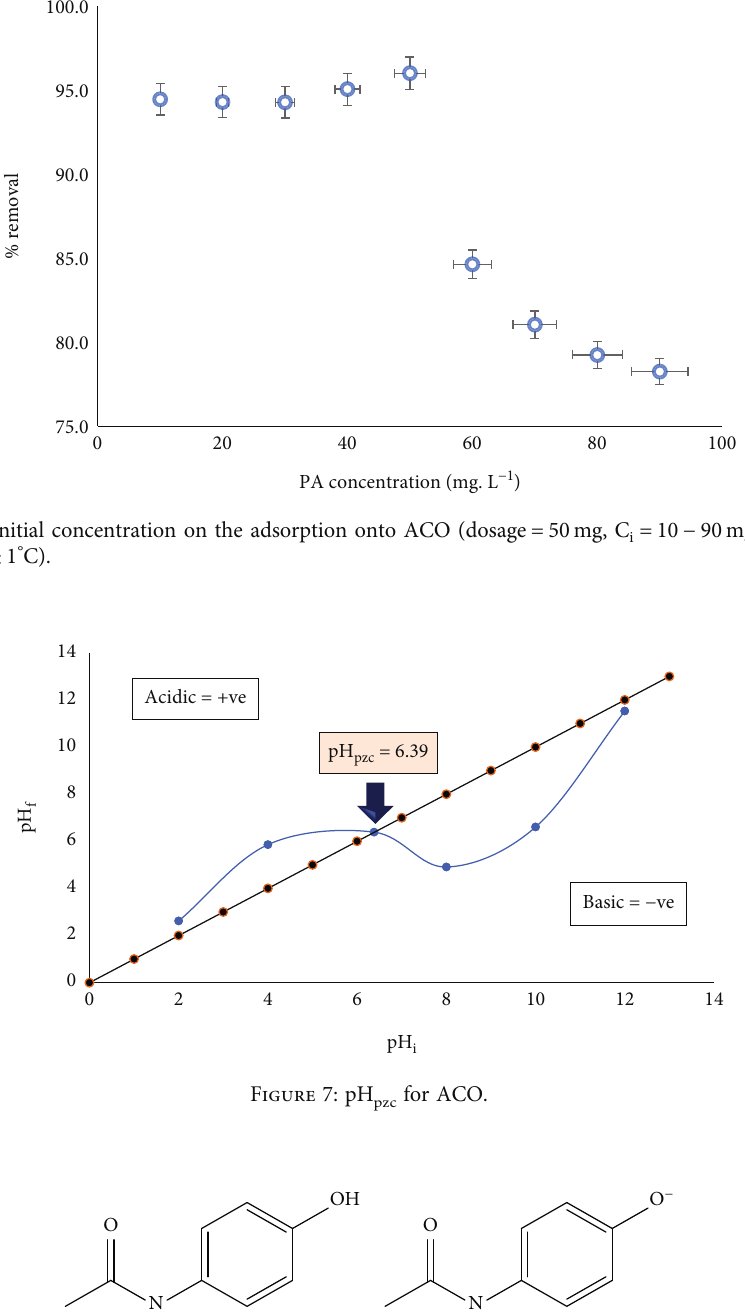
Scheme 2: Paracetamol (acetaminophen) structures in acidic and basic Table 2 summarized the R 2 and constants for kinetics models.